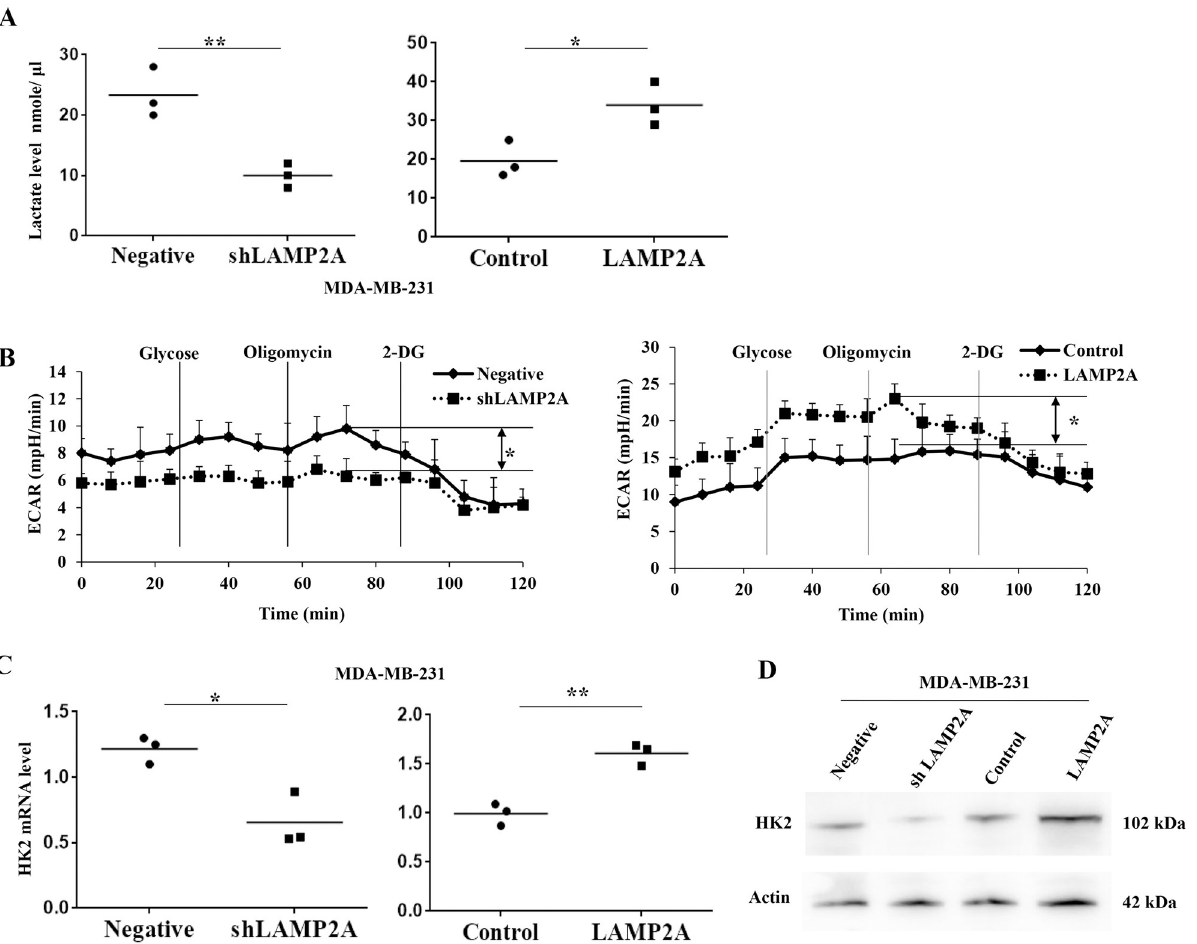
Fig 6. CMA promoted VEGFA expression through regulation of HK2-mediated aerobic glycolysis. (A) Lactate level was detected in TCM from MDA-MB-231 cells after LAMP2A knockdown or overexpression. (B) ECAR was detected in MDA-MB-231 cells with different LAMP2A expression, followed by injection of (vertical line) glucose (25 mM), oligomycin (1 μ M), and 2-DG (50 mM). (C) HK2 mRNA expression level was detected by real- time PCR in MDA-MB-231 cells after LAMP2A knockdown or overexpression. (E) HK2 protein expression level was detected by Western blotting in MDA-MB-231 cells after LAMP2A knockdown or overexpression. All values are representative of three different experiments; � P < 0.05, �� P < 0.01.